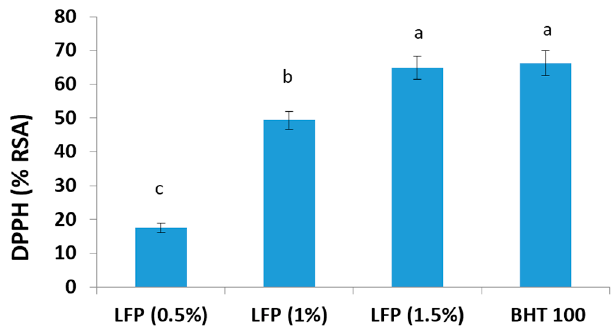
Figure 2. DPPH radical scavenging activity in litchi fruit pericarp extracts (0.5%, 1.0% and 1.5%) and BHT (100 ppm). Mean values bearing different superscripts (a, b and c) differ significantly ( p < 0.05).